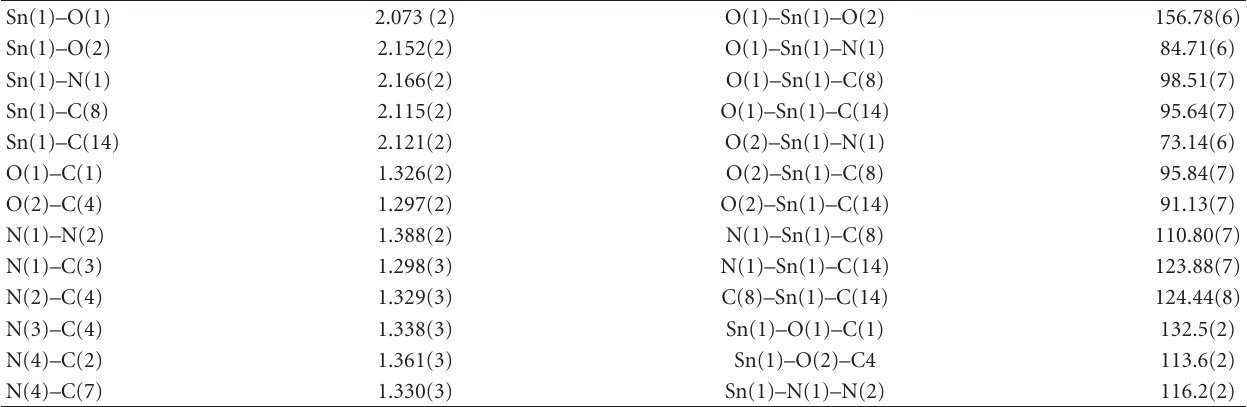
Table 2: Selected bond lengths (˚A) and angles ( ◦ ) for complex 2 .